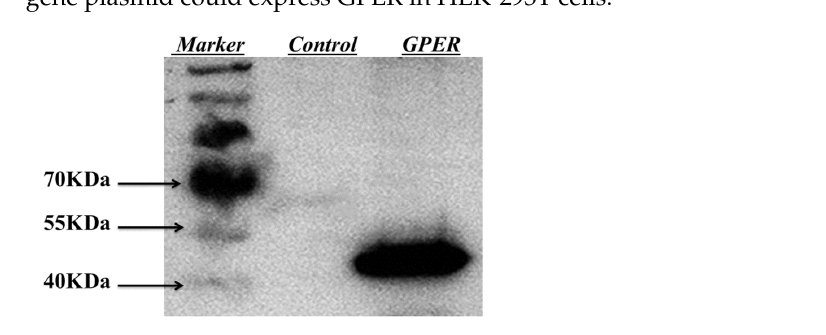
Figure 1. Western blo tt ing of GPER; Characterization of the e ff ect of the GCE pretreatment.